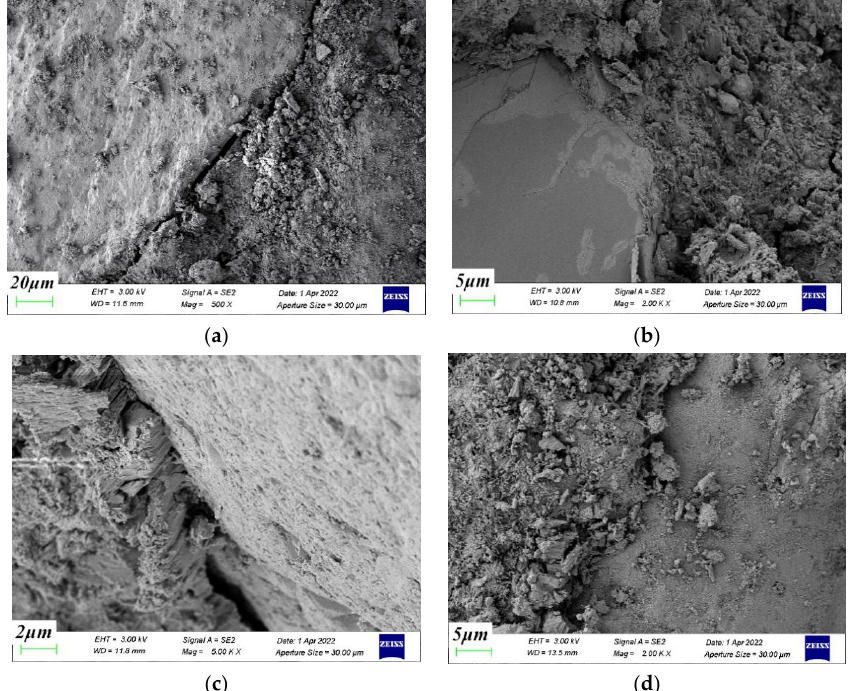
Figure 14. Coral aggregate–slurry interface transition zone. ( a ) 0 MPa, ( b ) 6 MPa, ( c ) 12 MPa, ( d ) 18 MPa.